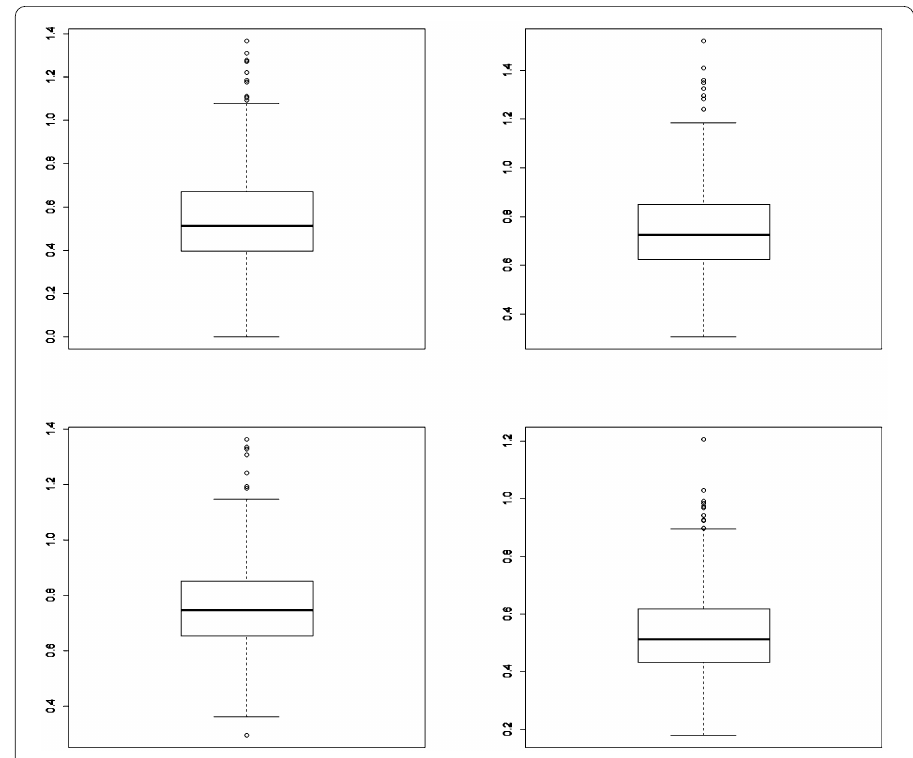
Figure 1 The two figures in first line are the Boxplot of estimated parameter α 1 , α 2 , respectively, for Model I with λ = 1. The two figures in second line are the Boxplot of estimated parameter p 1 , p 2 , respectively, for Model I with λ = 1. All Boxplots are obtained with sample size n =